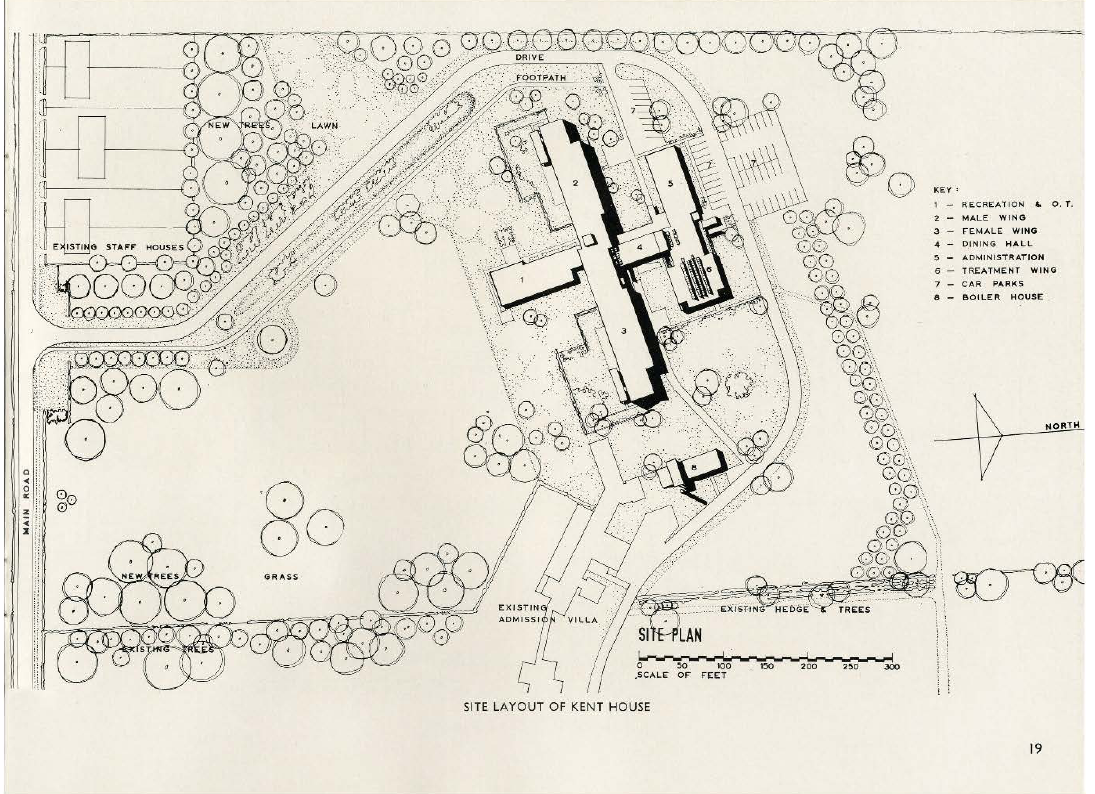
Figure 8. Post-war Admission Villa, Fulbourn Hospital, Cambridgeshire, site plan, 1964 (Source: ‘Programme for the opening of Kent House new admission unit, 1964’, p. 19, KHF/6/2/9, Cambridgeshire Archive Services, Ely, Cambridgeshire,